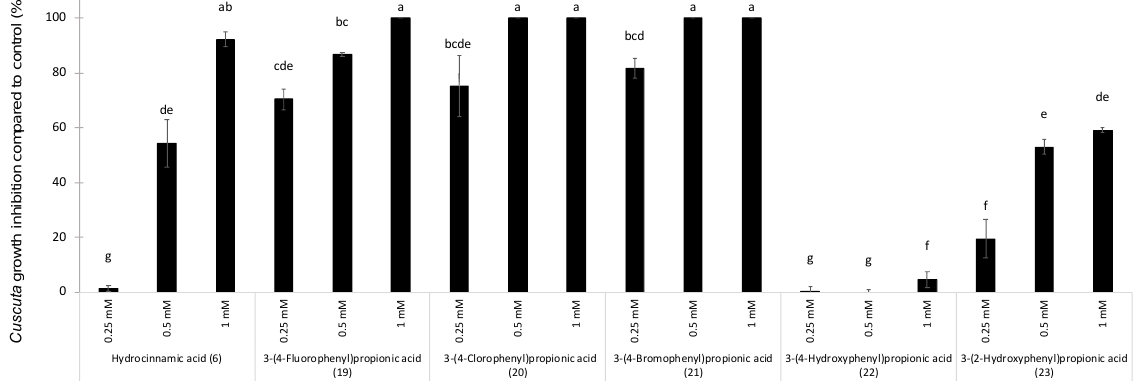
Figure 5. In vitro assessment of the Cuscuta growth inhibition induced by hydrocinnamic acid ( 5 ) and its derivatives ( 19 – 23 ). Bars with different letters are significantly different (Tukey test at p < 0.05).